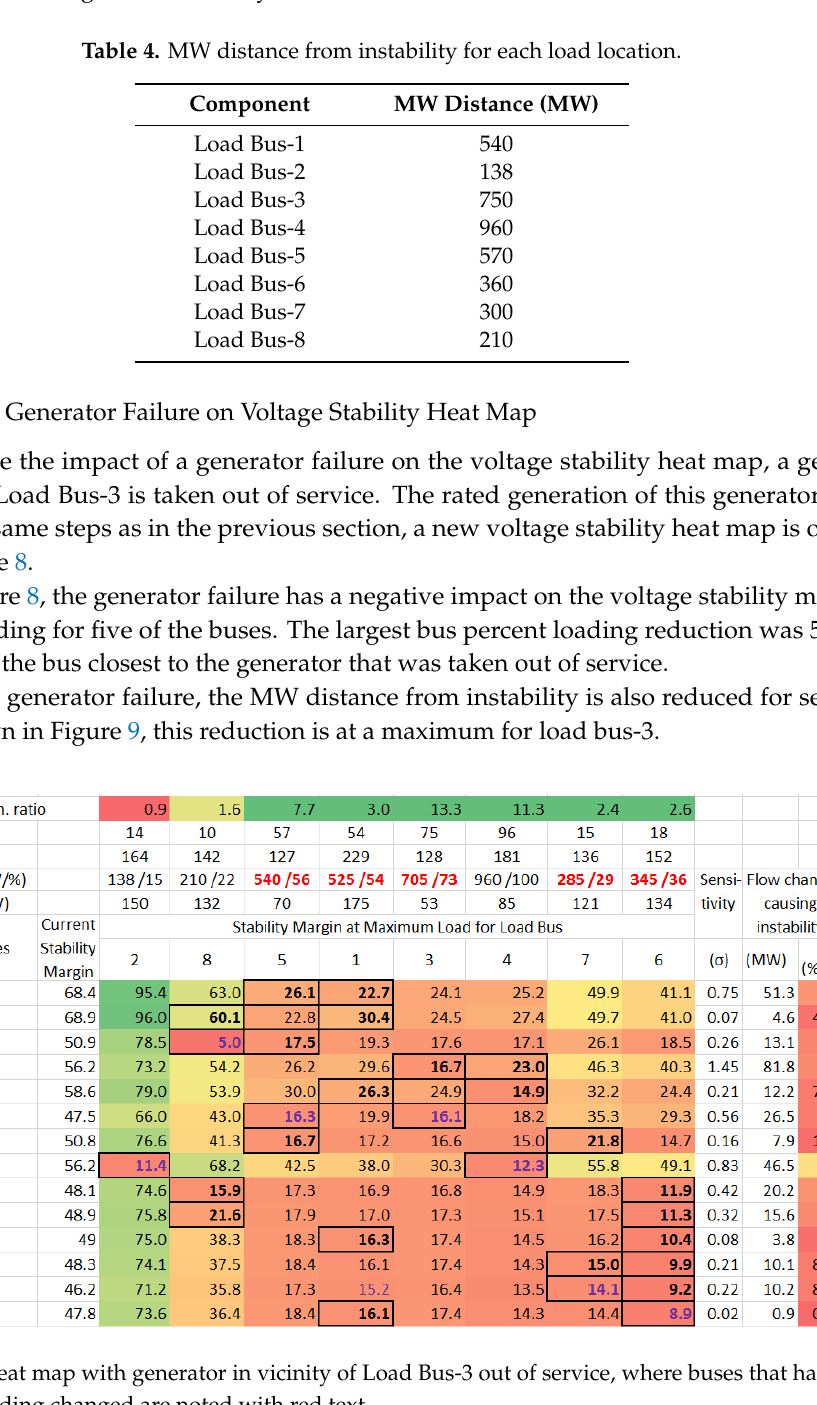
Figure 9. Impact of generator failure on MW distances. 4. Conclusions The use of a matrix-free, highly efficient GTA-based power flow is demonstrated for analyzing voltage stability of integrated T&D systems in the context of PV generation variability. Using sanitized models of real-world utility systems, it is shown that as the loading is increased on the system, stability margins decrease due to a decrease in voltages. However, as distributed PVs start generating, stability margins increase. This increase is different for different PV penetration levels. The relationship between PV penetration change and stability margin change is found to be non- linear. For the examples considered here, the change in the stability margin of a transmission line is approximately linearly related to the change in the loading of the transmission line for variations in